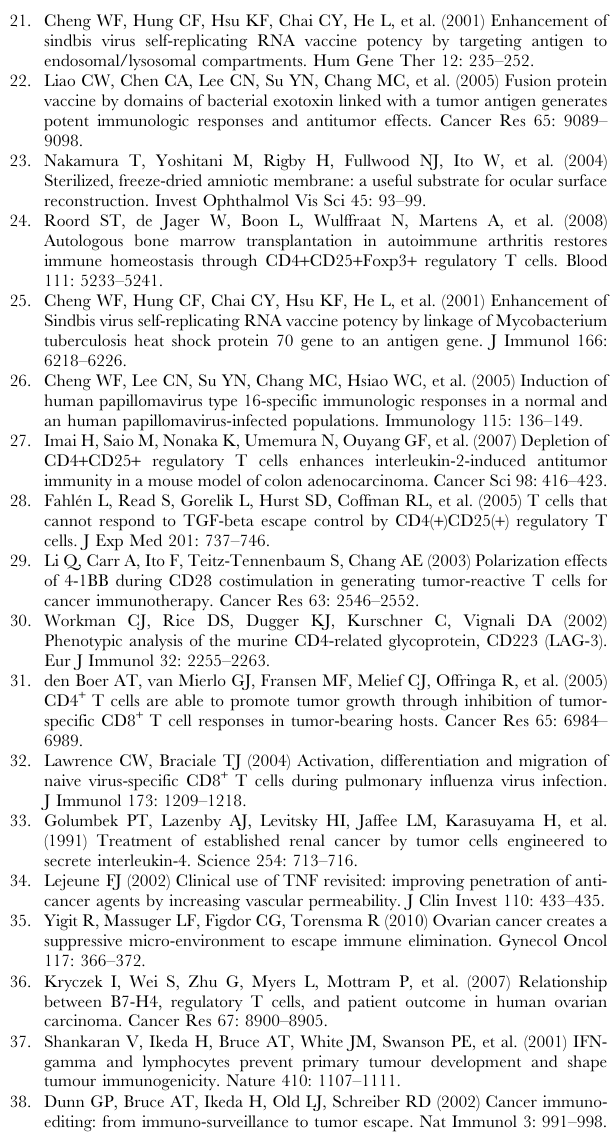
Figure S2 Representative figures of flow cytometric analyses of various kinds of local immune effectors in TACs of mice challenged with PBS or WF-3 tumor